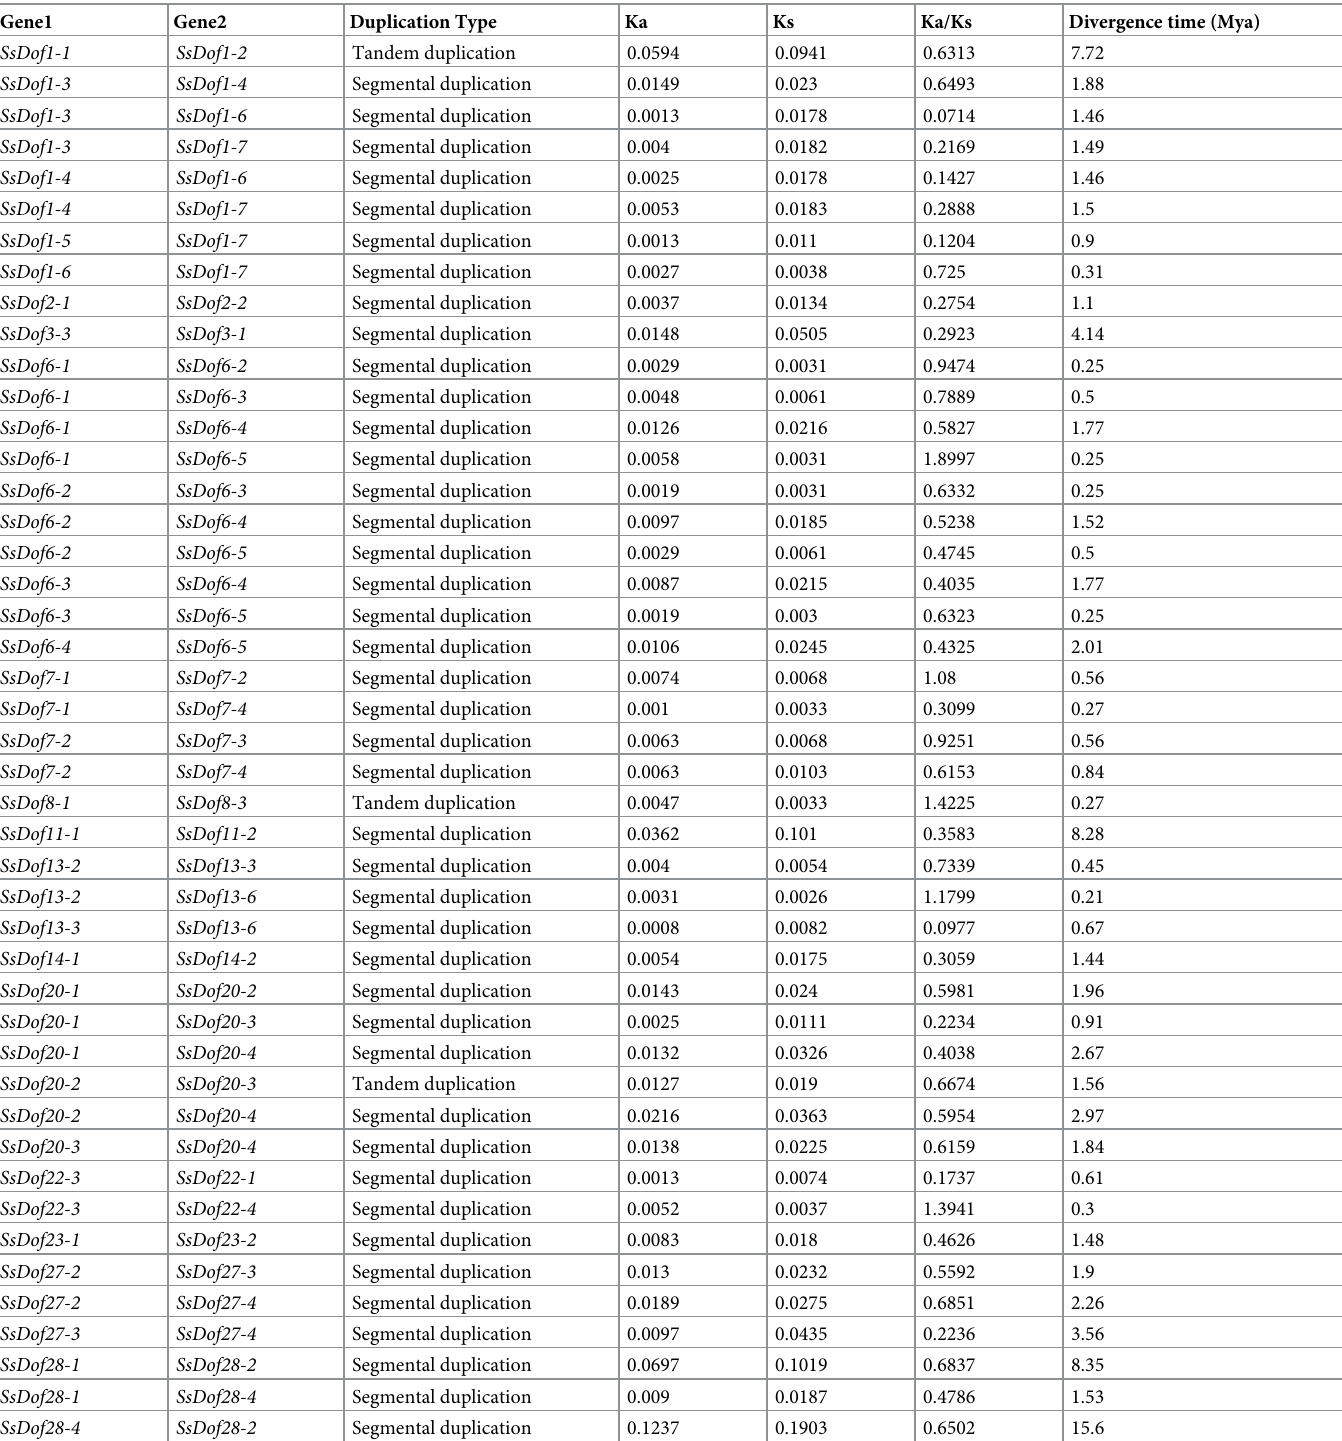
Table 4. Duplicated SsDof genes and the divergence time of SsDof genes.